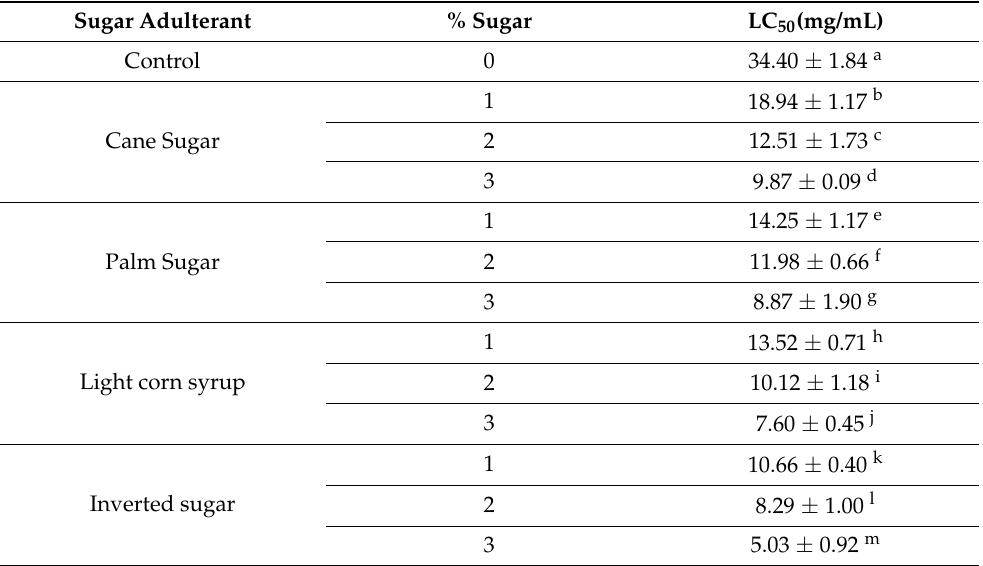
Table 2. The LC 50 of pure and sugar adulterated H. itama honey at 96